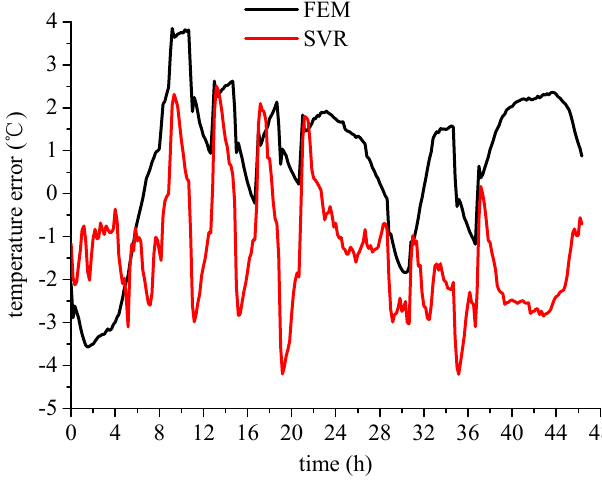
Figure 16. The temperature errors of the proposed method and FEM when λ a = 0.14 W/(m·K). Assuming that the thermal conductivity in thermal analysis λ a of armor wrap was 0.04 W/(m·K), the situation is totally different. As seen in Figure 17, the temperature errors of FEM are over 12 °C, much larger than those of SVR. This demonstrates a better generality of the proposed method.